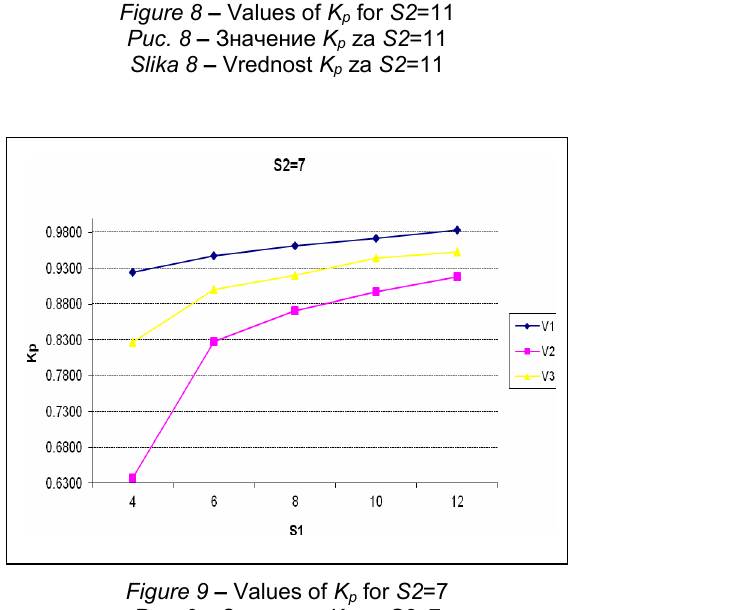
Figure 8 – Values of K p for S2 =11 Рис . 8 – Значение K p za S2 =11